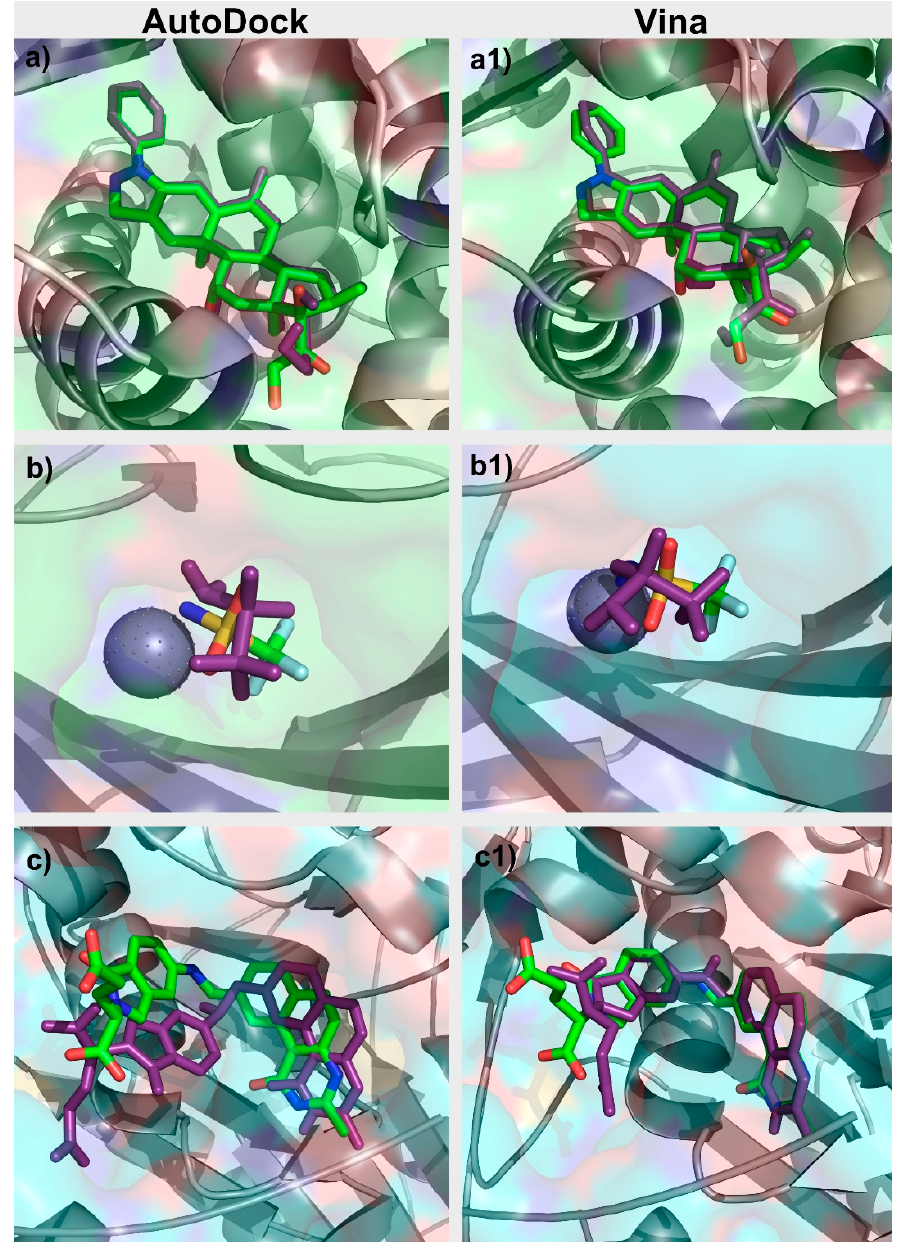
Figure 2. Comparison between the crystallographic (green) and “docked” (purple) poses of ( a ) glucocorticoid receptor (GCR) Autodock, ( a1 ) GCR Vina, ( b ) CAH2 AutoDock, ( b1 ) CAH2 Vina, ( c ) TYSY AutoDock, and ( c1 ) TYSY Vina .